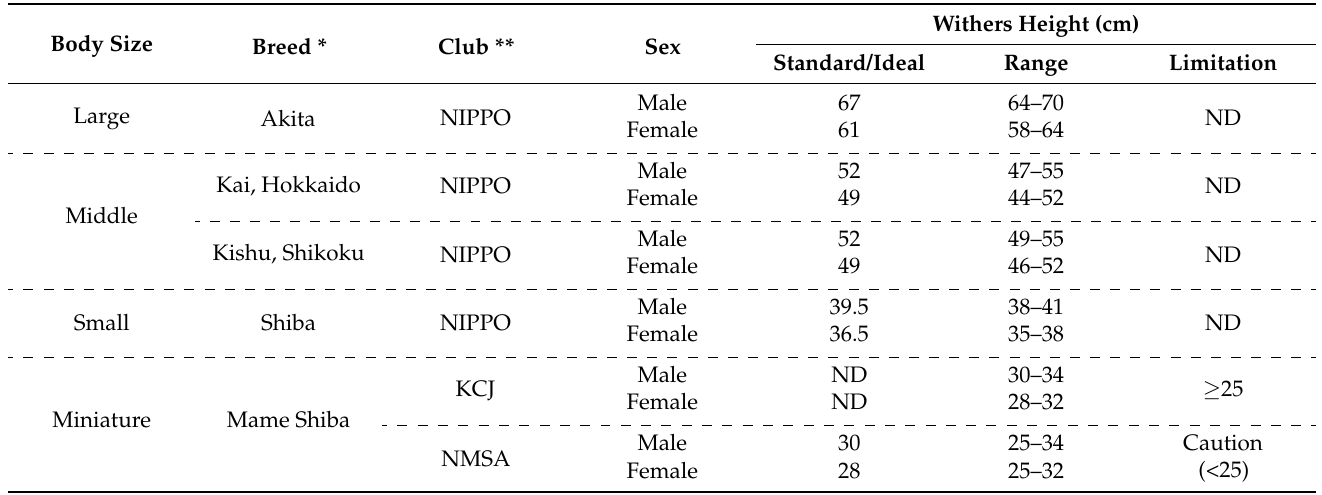
Table 1. Withers height of Japanese dog breeds.